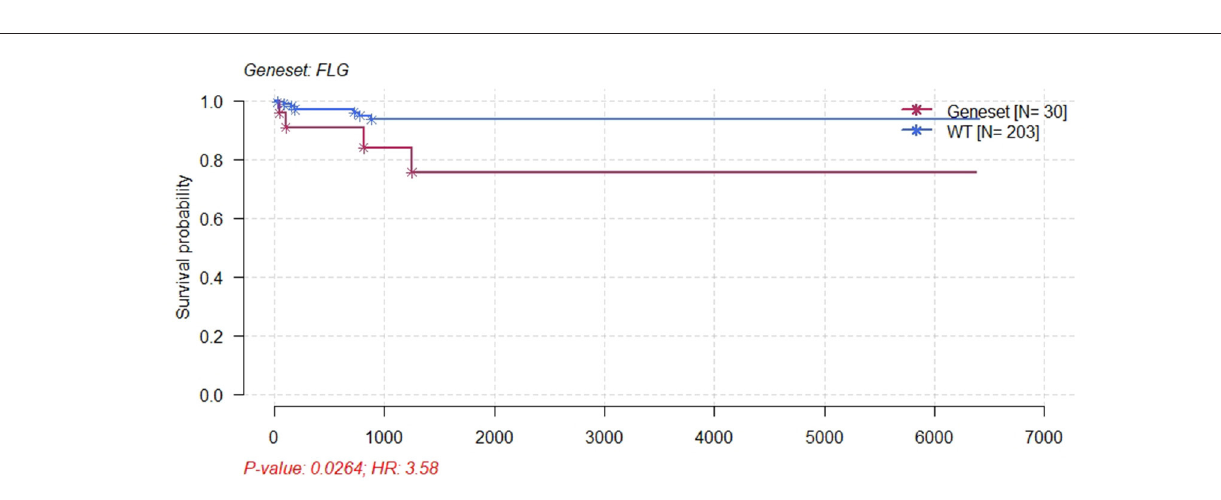
FIGURE 9 | Kaplan–Meier survival plot for FLG wild-type and patients with CESC mutants. Patients with CESC and FLG mutations had significant poor